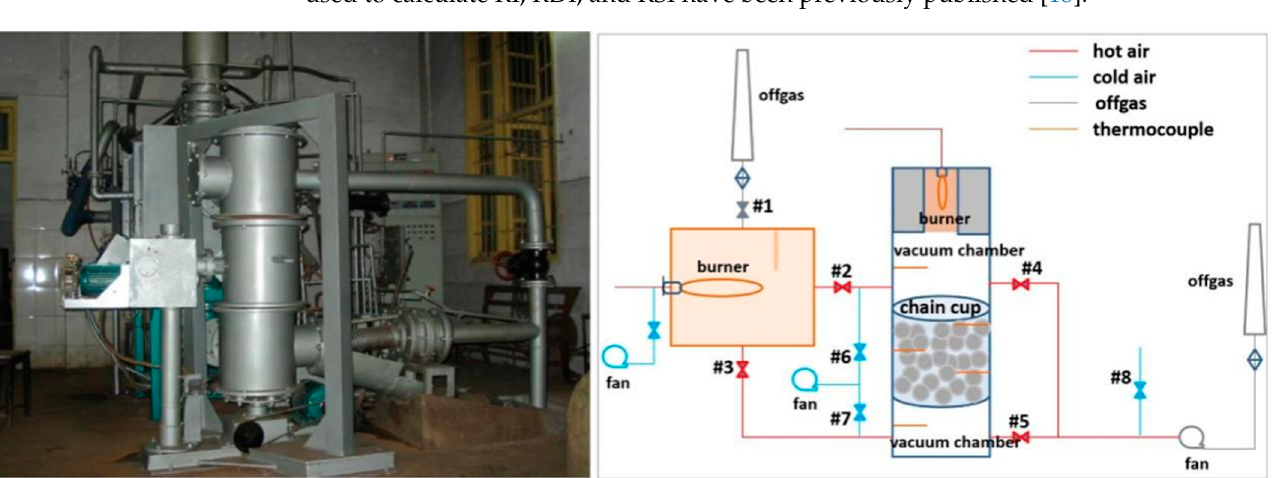
Figure 5. Photograph and schematic diagram of simulated straight-grate facility.